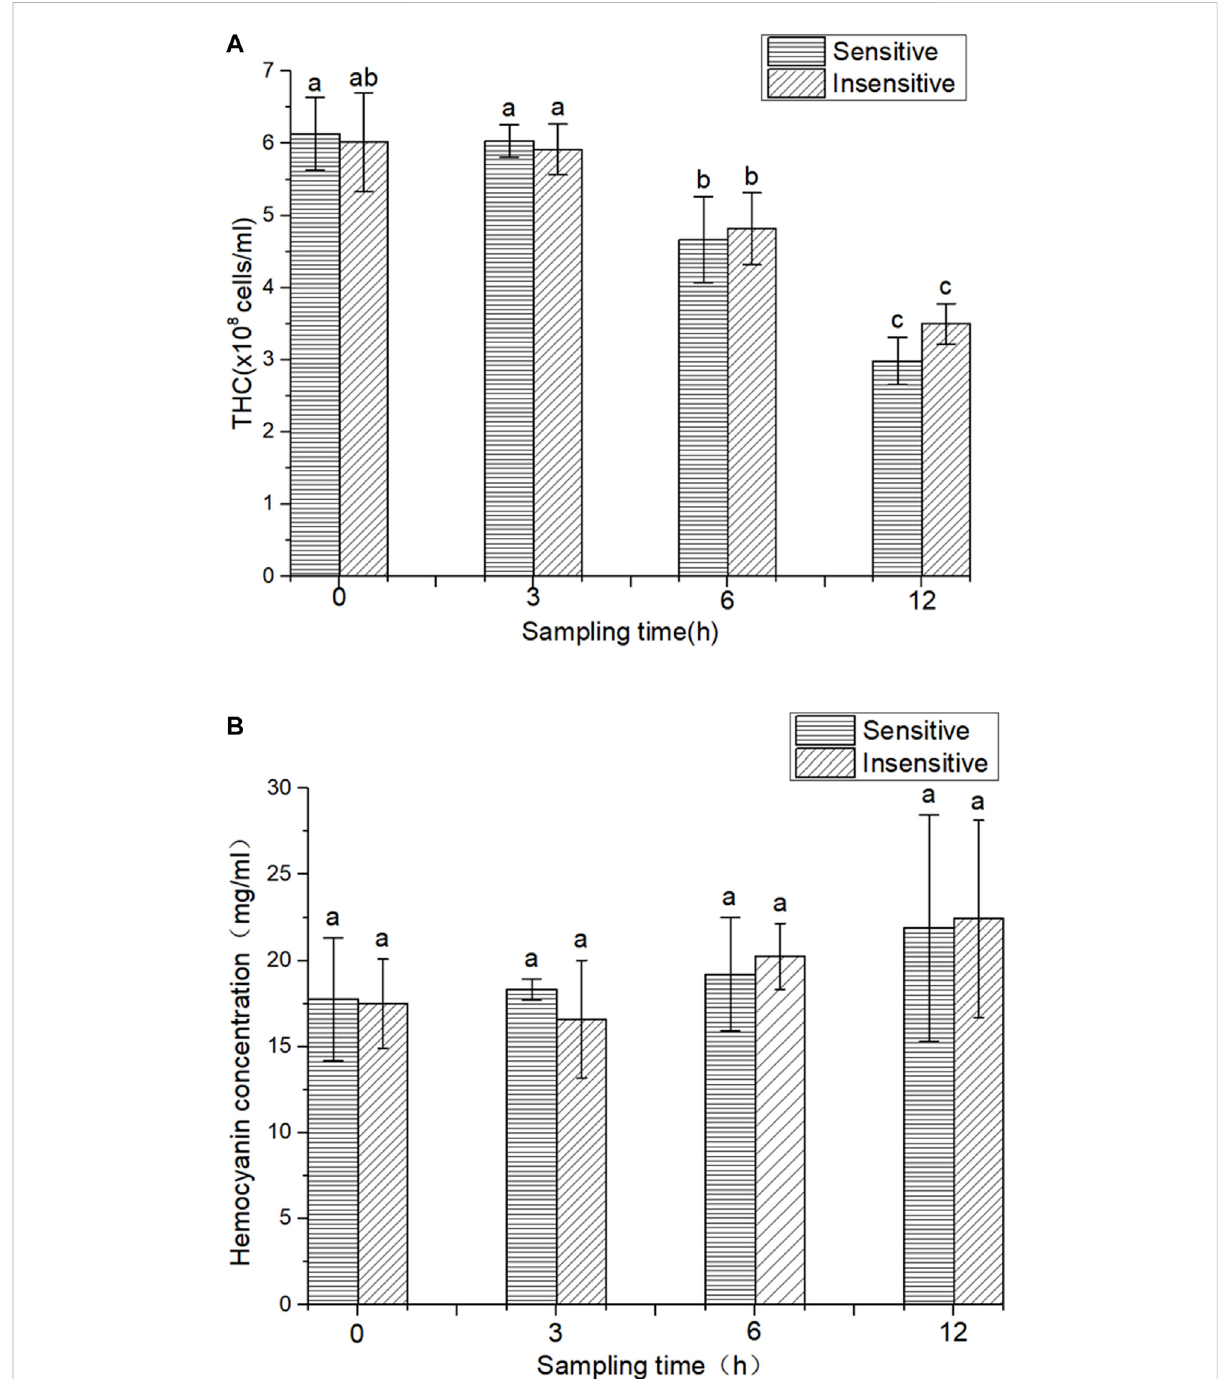
FIGURE 1 THC and HC in two strains of L. vannamei . (A) THC in two strains of L. vannamei, (B) HC in two strains of L. vannamei . Each bar represents the mean value of three determinations. The same letters in the data bar indicate no signi fi cant difference ( p > 0.01), while different letters indicate signi fi cant difference ( p <